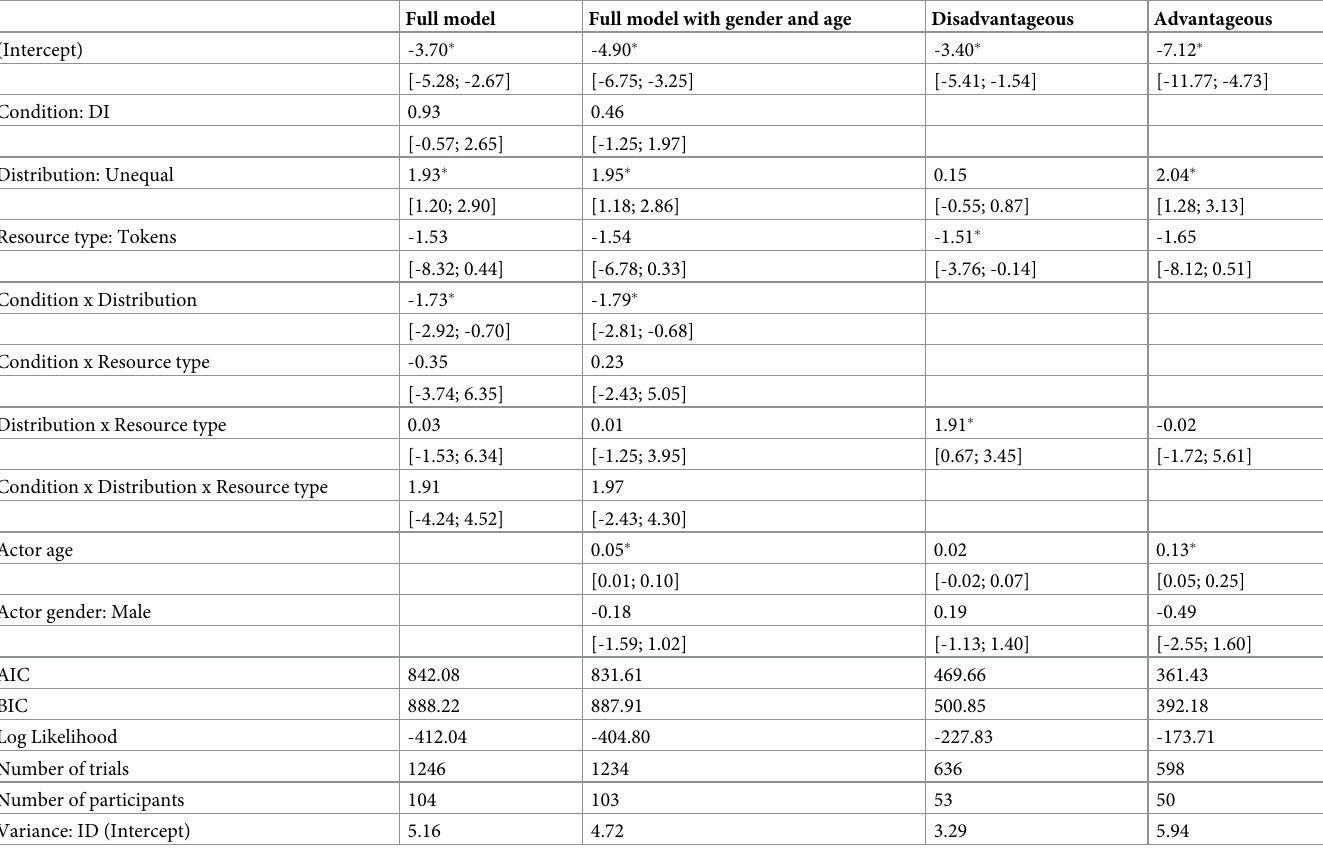
Table 1. Estimates and bootstrapped CIs ( N = 1,000 simulations) of fixed effects in Generalized Linear Mixed Models predicting children’s rejections (= 1) in the Inequity Game. Baselines were set as follow: Condition: AI; Distribution = Equal; Resource type = Skittles; Actor gender = Female. Table also shows goodness-of-fit